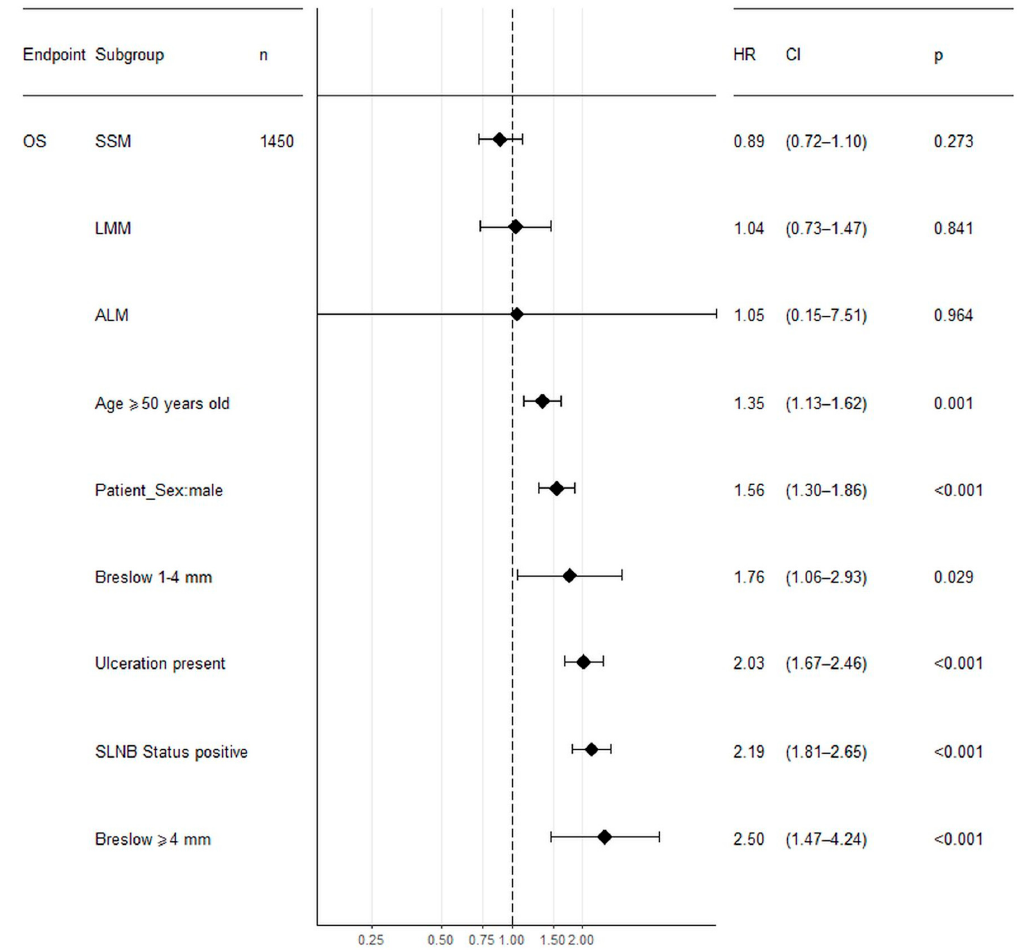
Figure 4. Forest plot showing the association between clinicopathological features and OS analyzed by multivariate analysis in non-HFM patients. Legend: SLNB—sentinel lymph node biopsy, NM—nodular melanoma, SSM—superficial spreading melanoma, ALM—acral lentiginous melanoma, LMM—lentigo malignant melanoma, CI—confidence intervals, HR—hazard radio, p — p -value, OS—overall survival.